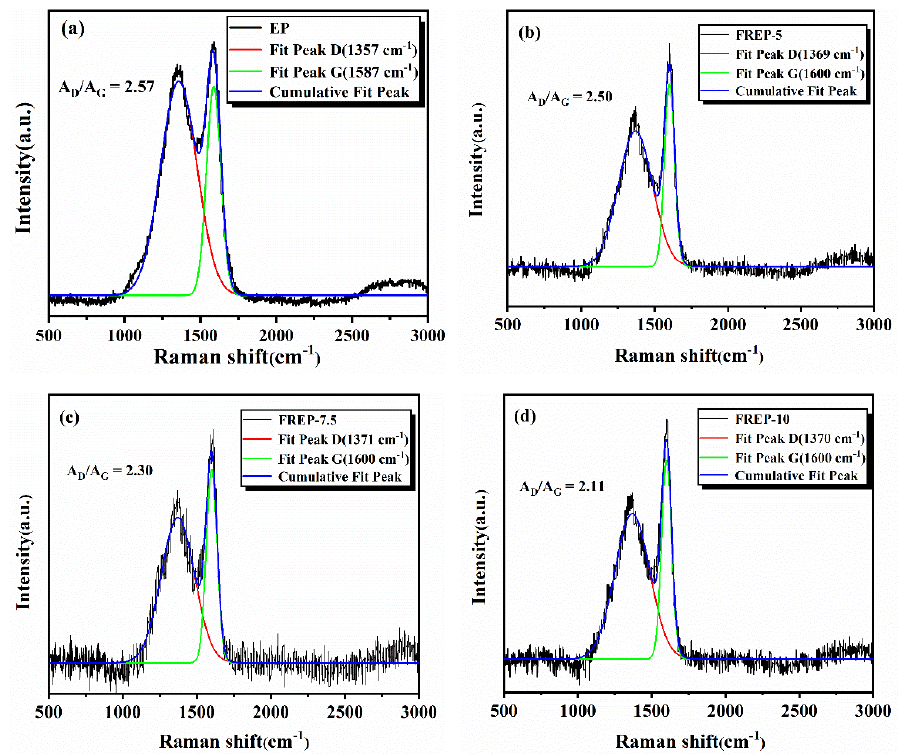
Figure 9. Raman spectra of char residues for EP ( a ), FREP-5 ( b ), FREP-7.5 ( c ) and FREP-10 ( d ).